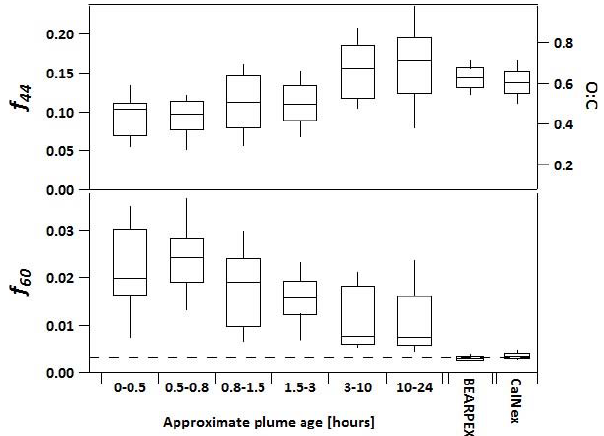
Fig. 3. Box and whisker plots representing the 10th, 25th, median, 75th and 90th percentiles for 245 BB plumes intercepted during ARCTAS. Classification of the plumes, and transport times shown on the horizontal axis, are adapted from Hecobian et al. (2011). Also shown are data from two ground campaigns free of BB influ-